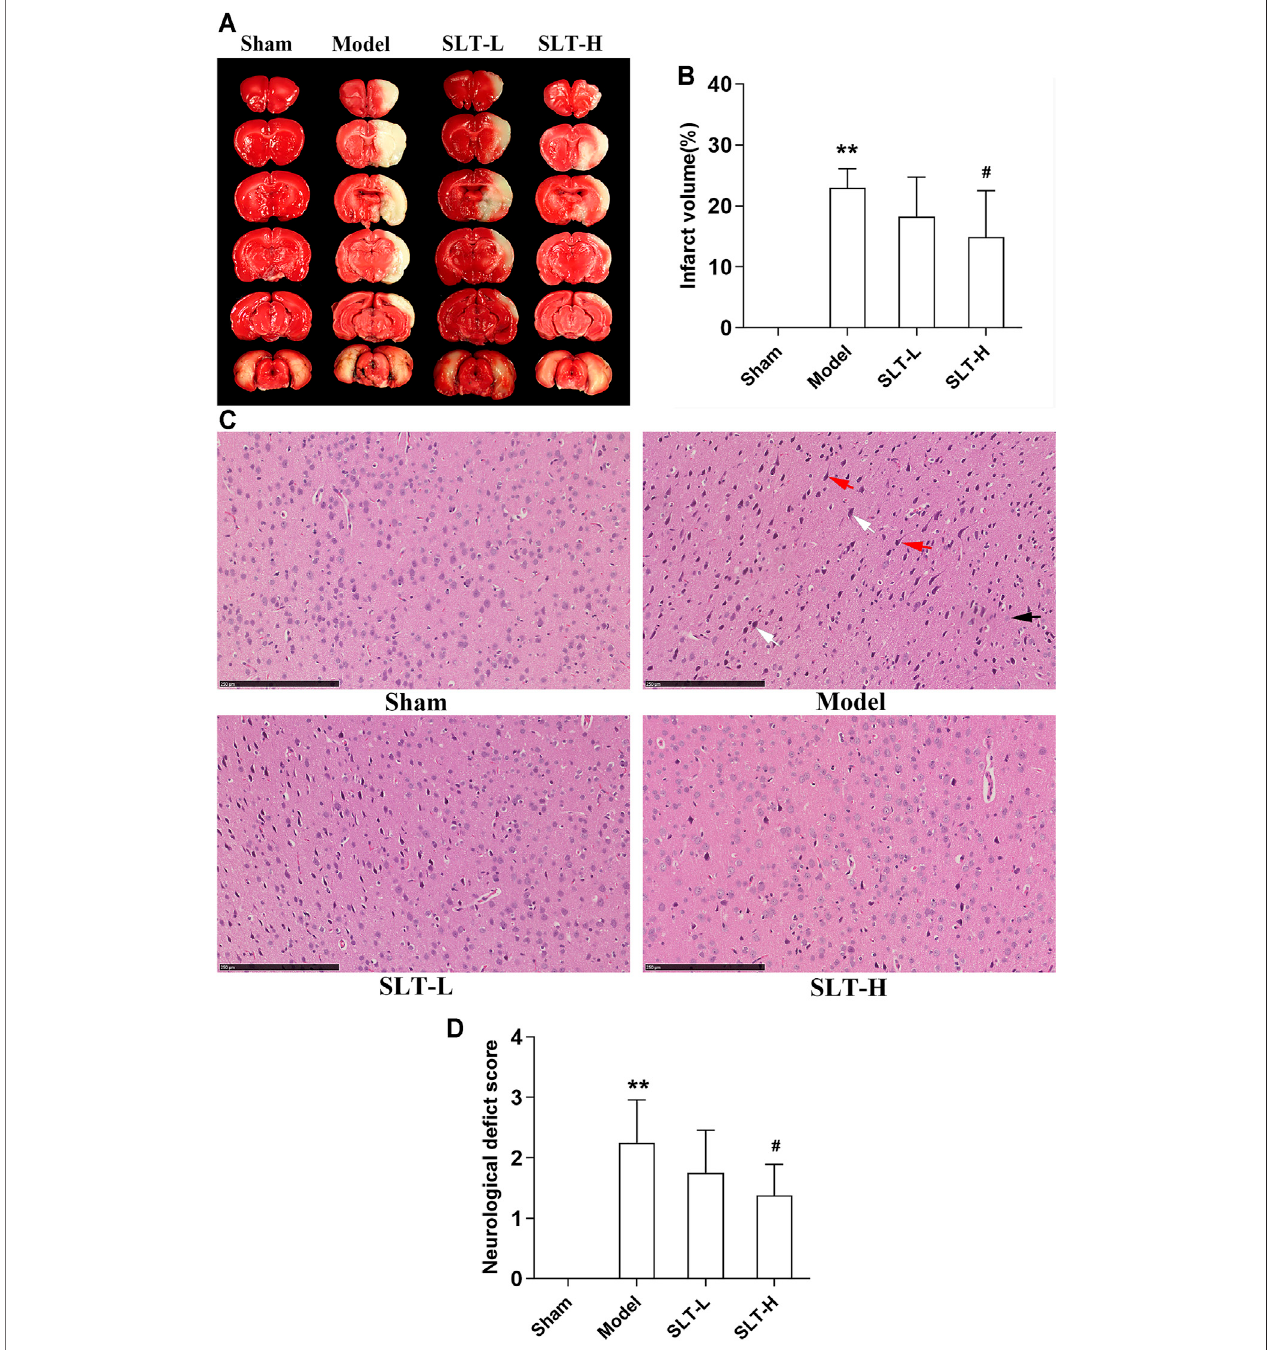
FIGURE 1 | SLT attenuated cerebral infarction and neurological de fi cit in rats undergoing MCAO. 24 h after MCAO, the rats were neurologically tested, then were killed,andtheirbrainswereharvestedforTTCandHEstainings. (A) RepresentativeimagesofTTCstaining.Thewhiteregionsaretheinfarcttissues,whiletheredregions are the viable tissues. (B) Infarct volumes of the brains ( n (cid:1) 8). (C) Representative images of HE staining of the brain cortex in all the groups. The ischemic brain region in the model group presented severe neuronal loss and neuron degeneration, including cytoplasm acidophilic degeneration (indicated with white arrows), nuclear pyknosis (indicated with red arrows), and hydropic degeneration (indicated with black arrow). The neuronal damages were alleviated in SLT-L and SLT-H groups (scale bar in all panels (cid:1) 250 μ m). (D) Neurological de fi cit scores of all the groups ( n (cid:1) 8). Data are expressed as mean ± SD. * p < 0.05, ** p < 0.01, in comparison to the sham group; # p < 0.05, in comparison to the model